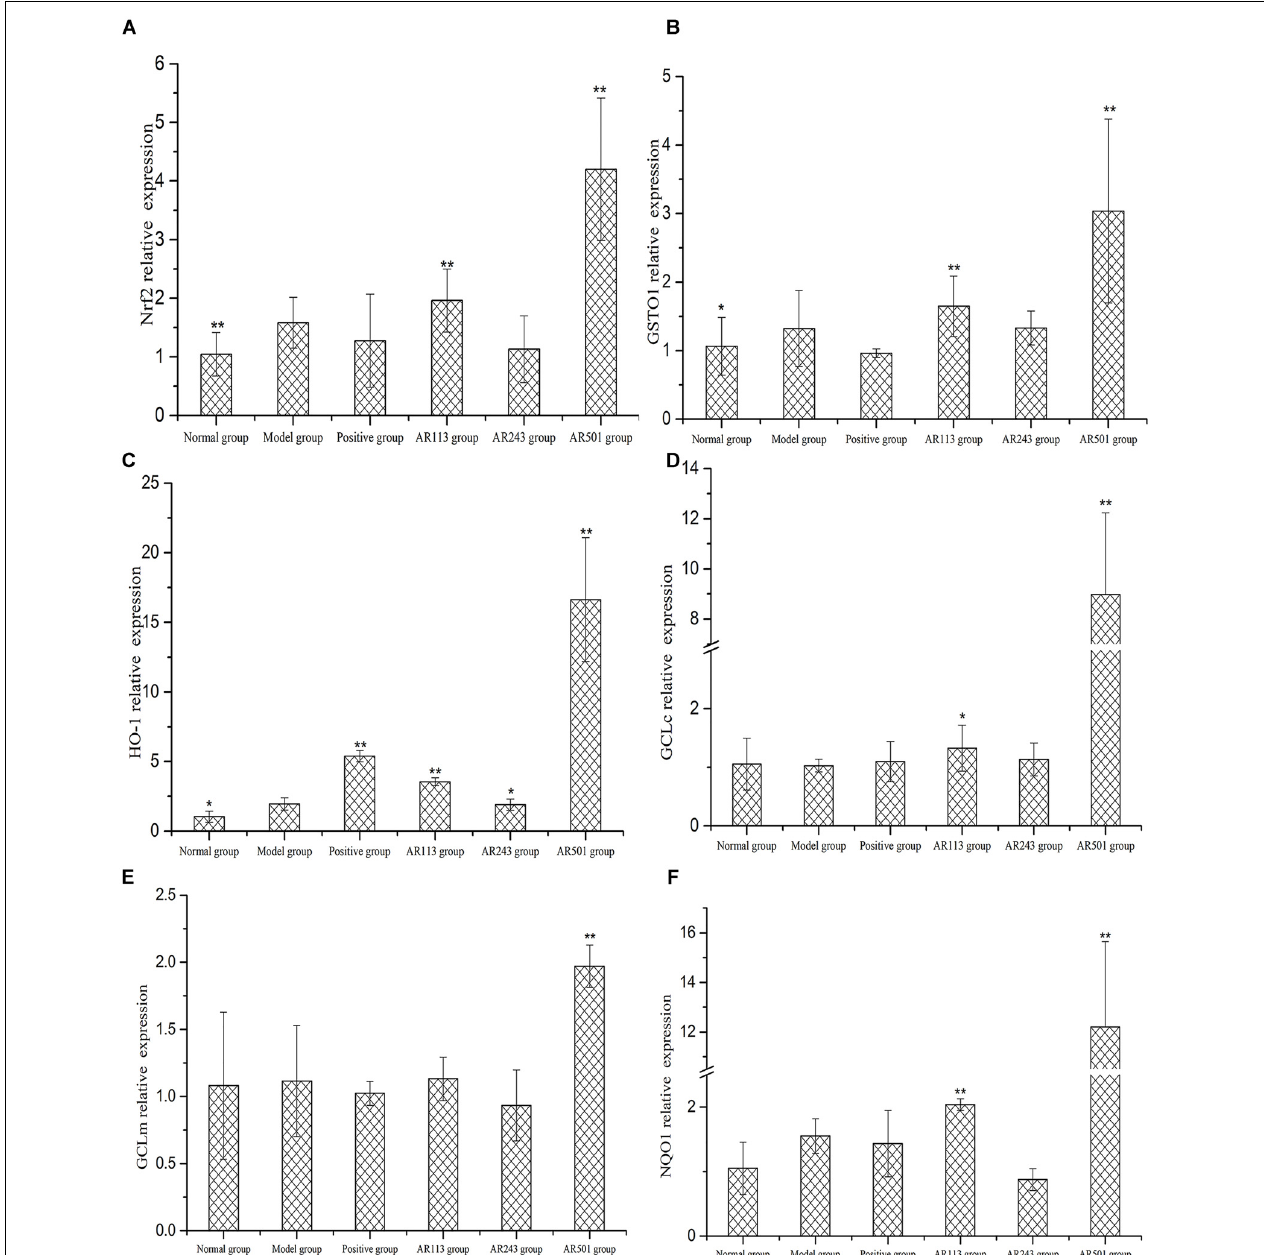
FIGURE 5 | Effect of LAB on oxidized oil induced changes of gene expression of Nrf2 (A) , GSTO1 (B) , HO-1 (C) , GCLc (D) , GCLm (E), and NQO1 (F) in liver of mice. Values are expressed as mean ± SD ( n = 10), ∗ p < 0.05 vs. model group, ∗∗ p < 0.01 vs. model group.